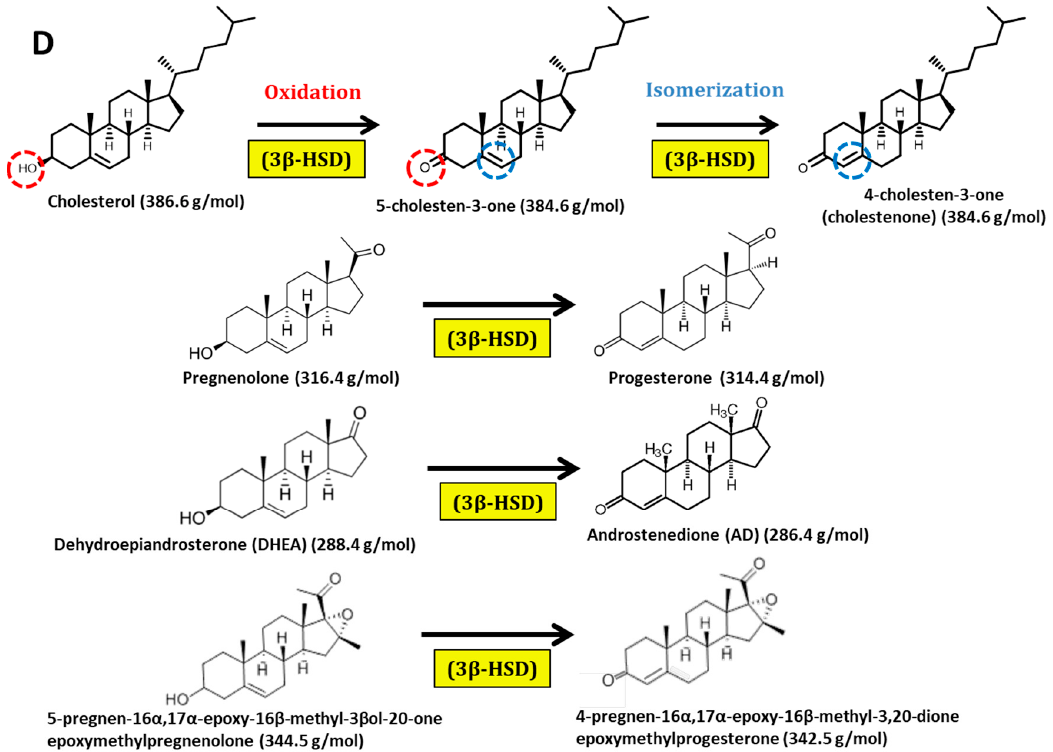
Figure 1. Expression of MSMEG_5228 gene from M. smegmatis in heterologous hosts. ( A ) SDS-gel electrophoresis of protein extracts. Lane 1 Molecular weight marker; Lanes 2 and 3, soluble and pellet fractions from E. coli (pET5228). ( B ) Lanes 1 and 6, Molecular weight markers; Lanes 2 and 3, soluble and pellet fractions from R. erythropolis (pTipQC1), respectively; Lanes 4 and 5, soluble and pellet fractions from R. erythropolis (pTip5228), respectively. ( C ) Lanes 1 and 3, soluble and pellet fractions from C. glutamicum R31 (pCGL5228), respectively. Lane 2, Molecular weight marker. ( D ) Reactions studied in this work that are carried out by the 3 β -HSD mycobacterial